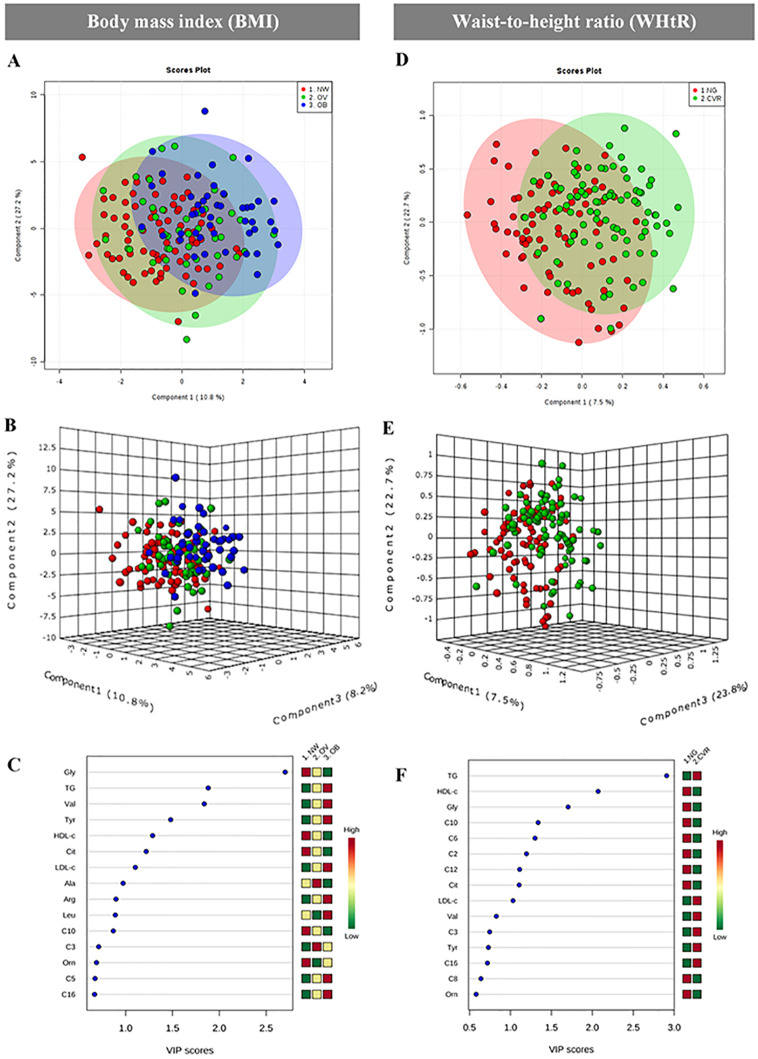
Metabolites profile in serum from schoolchildren classified by BMI and WHtR.(A—C) BMI classification; (D—F) WHtR classification. PLS-DA plots and loadings plots showing the maximum covariance between metabolites concentrations and the largest effect by children adiposity group.